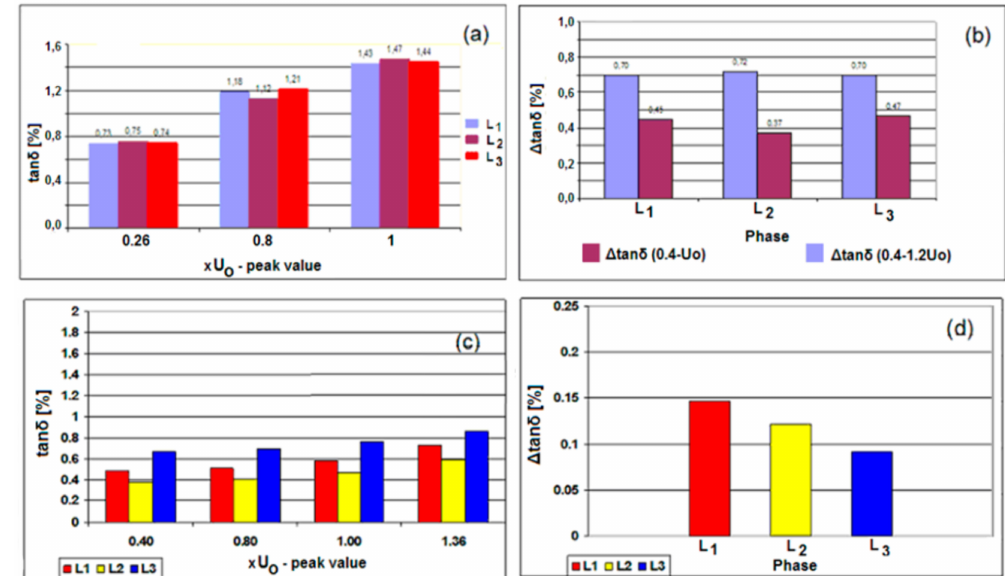
Figure 5. Example of dissipation factor diagnosis data as obtained for two di ff erent cable circuits: ( a , b ) A 150 kV power cable with self-contained fluid-filled (SCFF) insulation, length: 850 m, aged 49 years, ( c , d ) A 230 kV power cable with low-pressure fluid-filled (LPFF) insulation, length 13.3 km, aged 33 years.